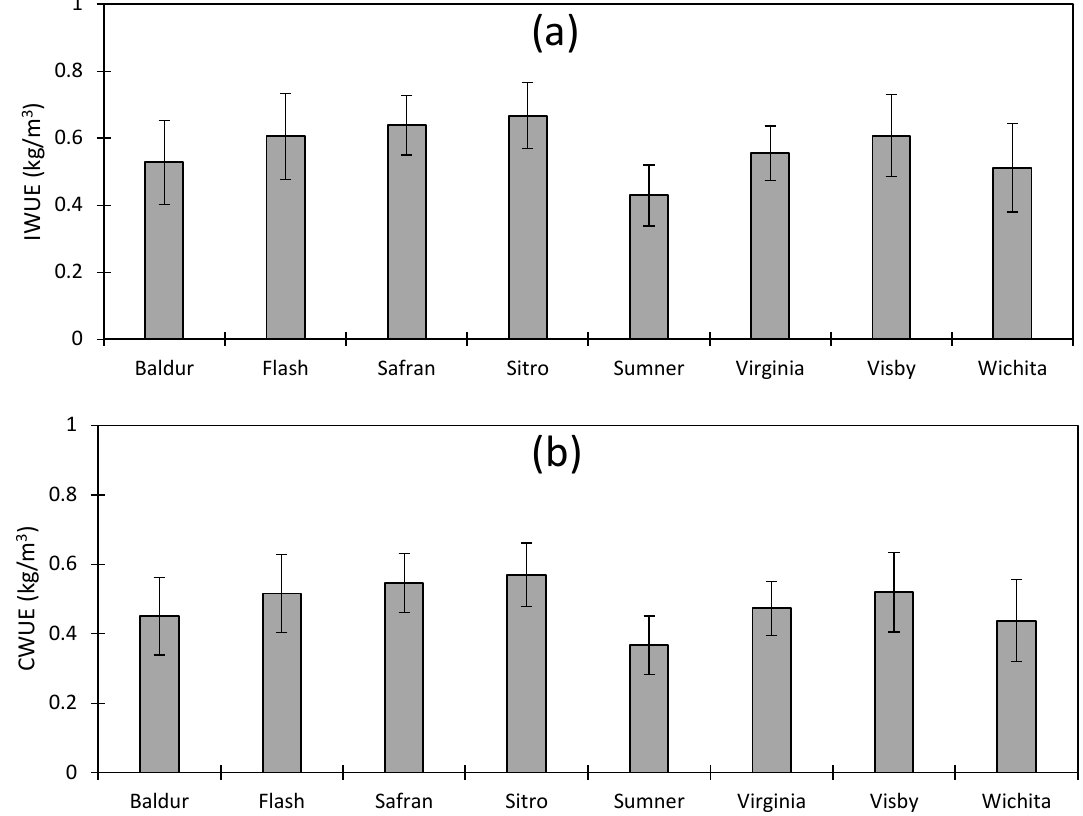
Figure 8. Trends in canola ( a ) IWUE and ( b ) CWUE as functions of canola variety (Error bars are standard deviations). IWUE, irrigation water-use efficiency; CWUE, crop water-use efficiency.